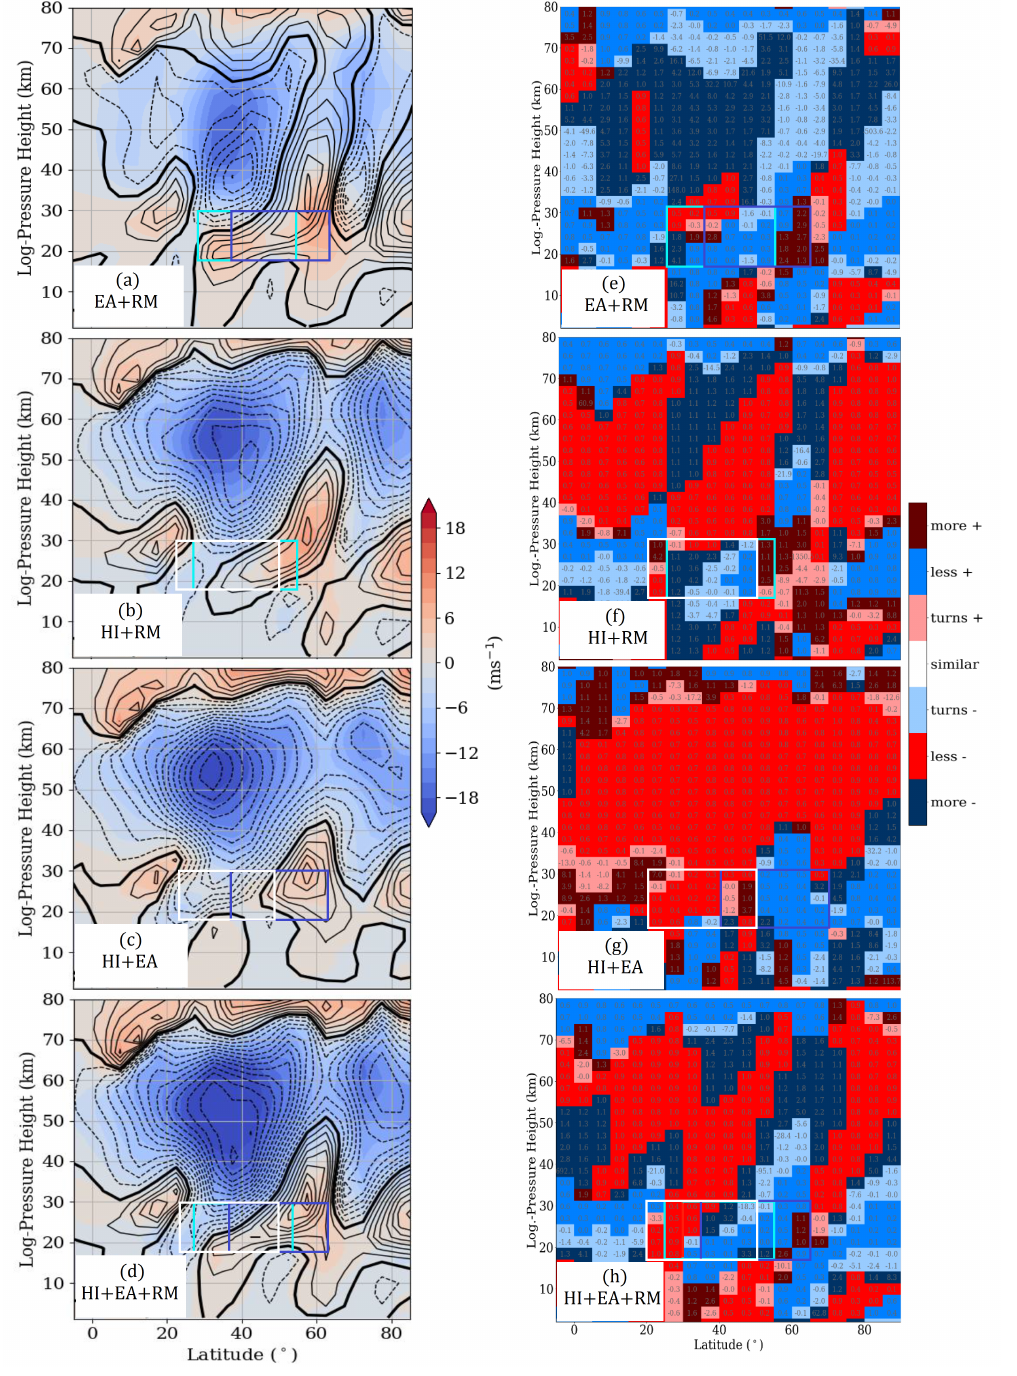
Figure 9. Stationary planetary wave 1 amplitude differences between the RM + EA ( a ), RM + HI ( b ), HI + EA ( c ) and RM + HI + EA ( d ) GW hotspots experiments and the Ref simulation in color coding. The contour lines show the sum of the single GW hotspot differences: (RM − Ref) + (EA − Ref) ( a ), (RM − Ref) + (HI − Ref) ( b ), (HI − Ref) + (EA − Ref) ( c ) and (RM − Ref) + (HI − Ref) + (EA − Ref) ( d ). The right figures show the differences between the two differences shown in the left figures: (RM + EA − Ref) − ((RM − Ref) + (EA − Ref)) ( e ), (RM + HI − Ref) − ((RM − Ref) + (HI − Ref)) ( f ), (EA + HI − Ref) − ((EA − Ref) + (HI − Ref)) ( g ) and (RM + HI + EA − Ref) − ((RM − Ref) + (HI − Ref) + (EA − Ref)) ( h ). Blue (red) areas indicate destructive (constructive) interference with respect to the stationary planetary wave (SPW) 1 activity. The numbers represent the linearity factor L (Equation